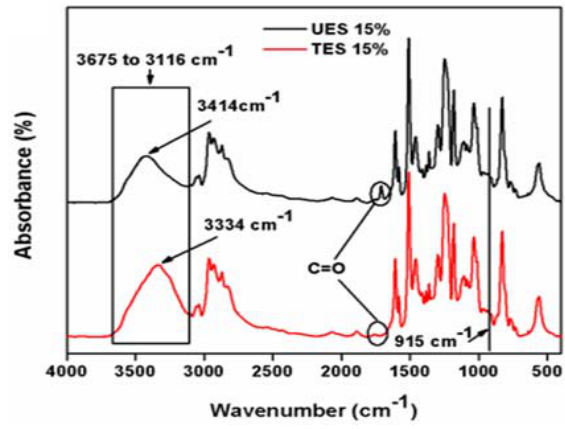
Figure 7. The FTIR spectra of 15% UES and 15% TES filled epoxy composites.